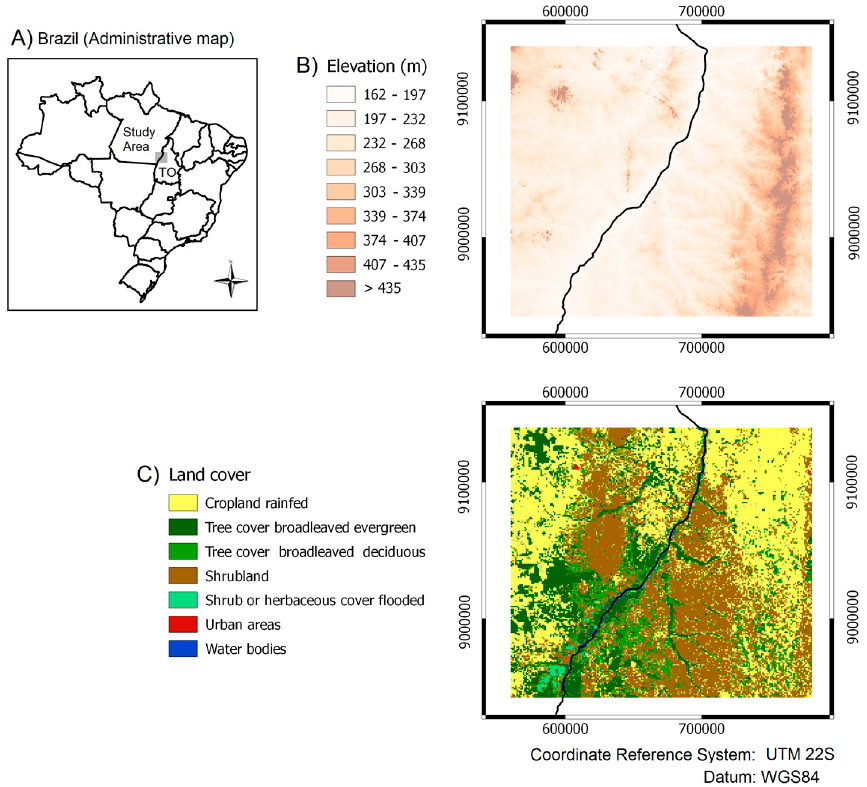
Figure 1. Study area (in gray) located in the northwestern part of Tocantins state (TO) over Brazil ( A ) Elevation ( B ) and land cover ( C ) maps (source: Shuttle Radar Topography Mission (SRTM 4.1, 90 m) [24] and ESA Land Cover CCI 2005 [25]) are also shown.